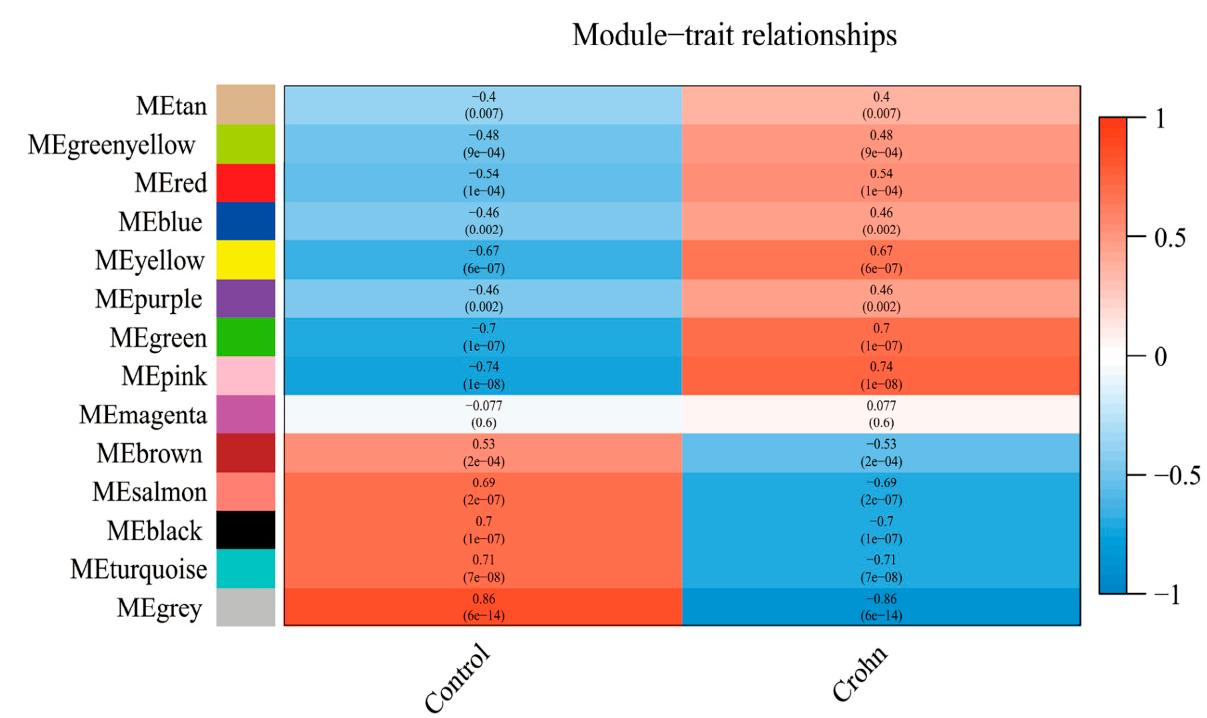
Figure 7. Heatmap of the module-clinical trait relationship. Clinical phenotypes are divided into two categories (control and Crohn’s disease). Each row represents a module eigengene (ME), and each column represents a clinical feature. The numbers in the first row in each cell are correlation values, and the numbers in the second row are p -values. The red cell color indicates that the module is positively correlated with the corresponding clinical feature, whereas blue indicates that the module is negatively correlated with the corresponding clinical feature. p < 0.05 is statistically significant.